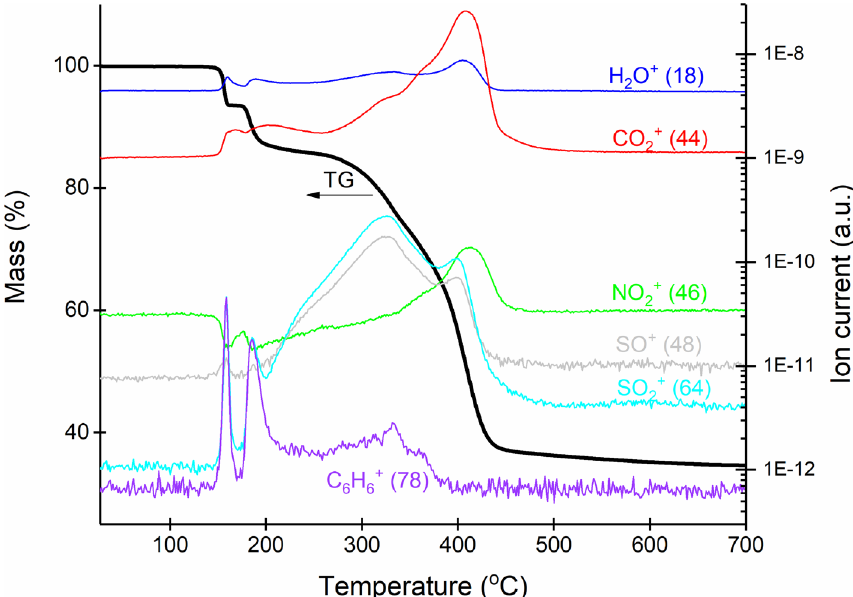
Figure 11. TG-MS curves of Ru-Pth complex (black line—TG curve, other lines—different m/z peaks).